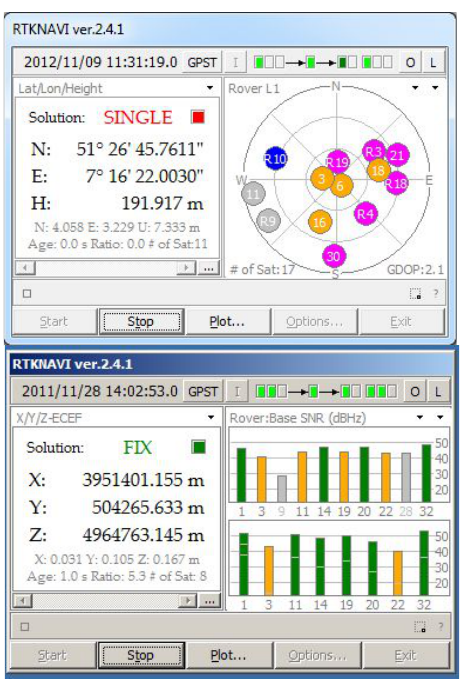
Figure 7. Multi sensor circuit board with